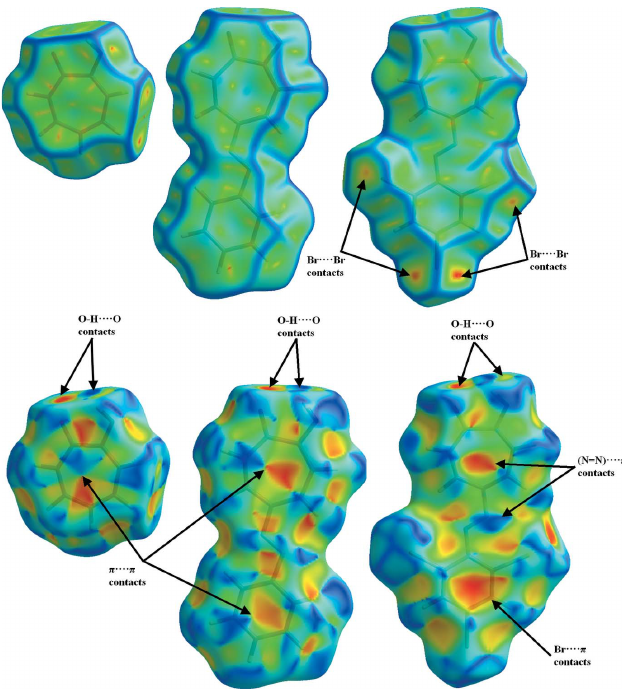
Figure 4 Hirshfeld surfaces for tropolone, 5-phenyltropolone and I , mapped with curvedness (top) and shape index